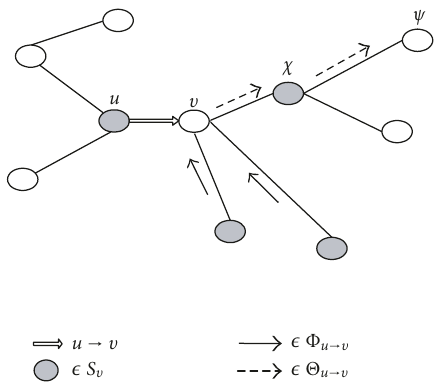
Figure 1: Example transmission u → v , set of nodes S v , and trans- missions that belong in Φ u → v or Θ u → v